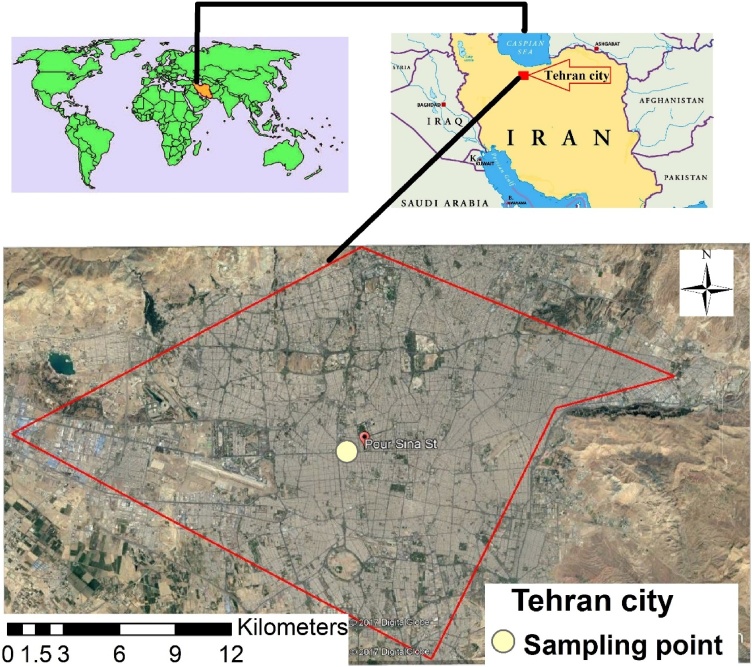
Map of the study area and PM10 sampling point.